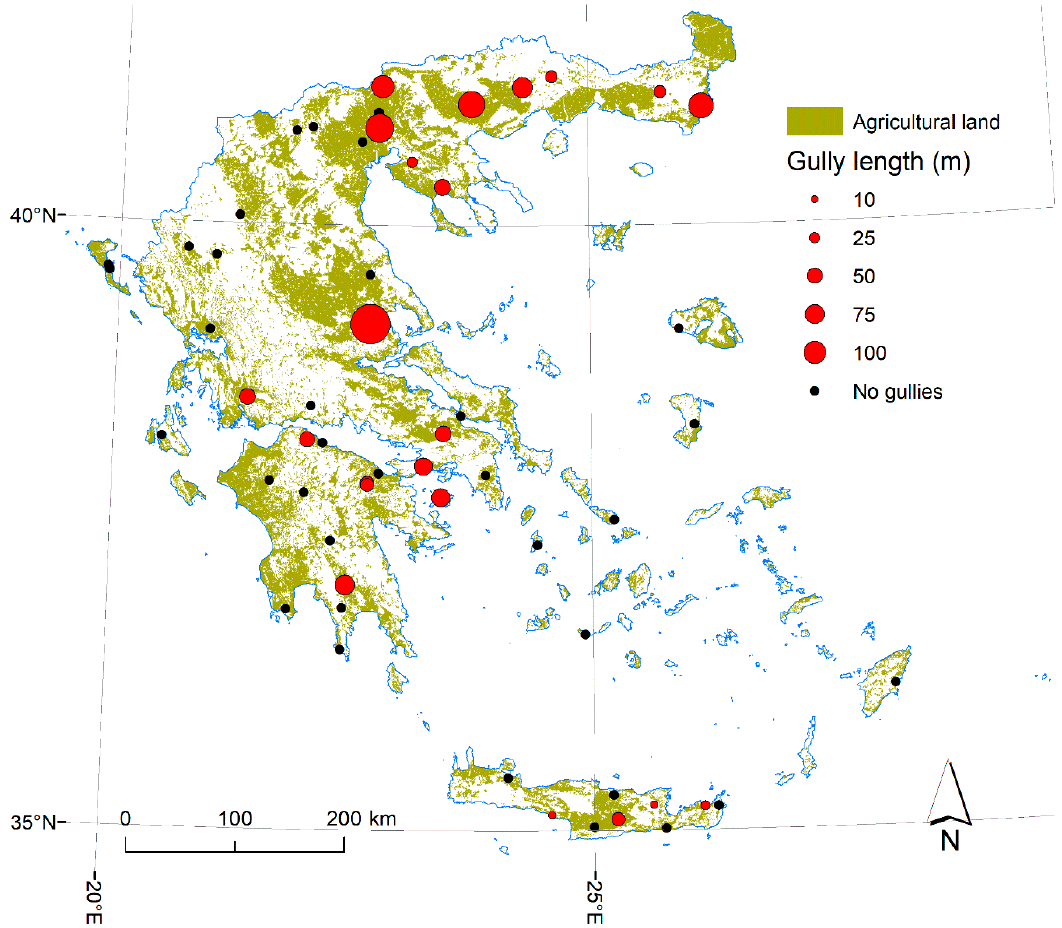
Figure 3. Geographic distribution of the total gully length per randomly sampled site (graduated symbol in five categories of magnitude).